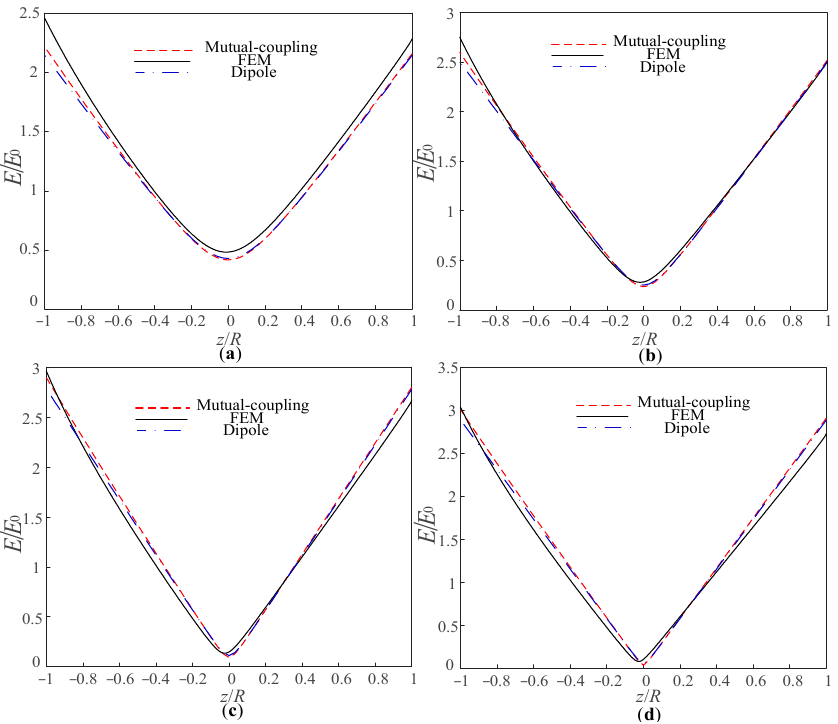
Figure 8. Calculation results of the electric field distribution on particle 1 when D / R = 1.5: ( a ) Calculation results when ε i / ε e = 5; ( b ) Calculation results when ε i / ε e = 10; ( c ) Calculation results when ε i / ε e = 25; ( d ) Calculation results when ε i / ε e = 50.